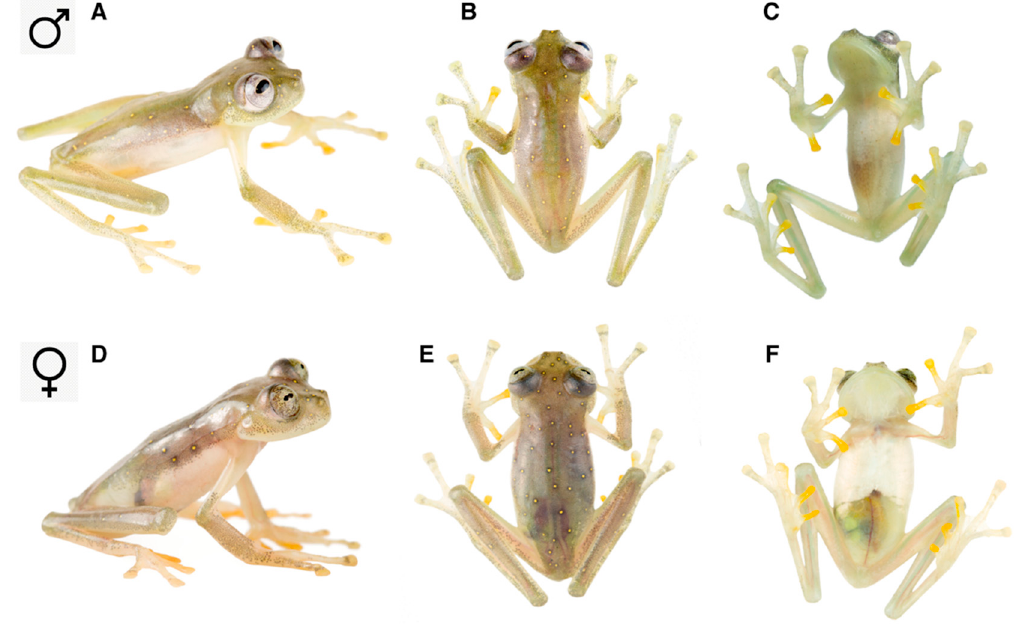
Figure 170. Nymphargus manduriacu in life from Reserva Río Manduriacu, Imbabura province. ( A – C ) Adult male, ZSFQ 0466. ( D – F ) Adult female, ZSFQ 0462. Photos by Jose Vieira/Tropical Herping. Obtained from Guayasamin et al. [194].